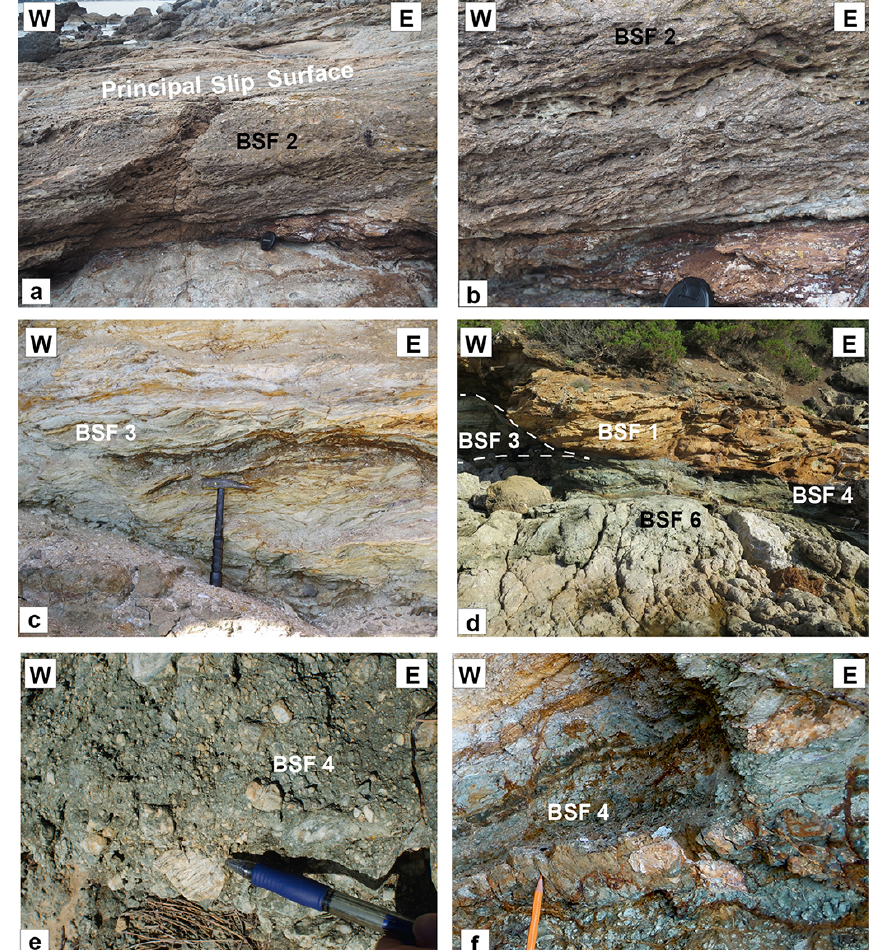
Figure 5. Outcrop view of fault rocks from different BSFs. Panels (a, b) show BSF 2. (a) Upper yellowish cohesive cataclasite with gently W-dipping foliation capped by the subhorizontal ZF principal slip surface. (b) Detail of foliated cataclasite with oblique foliation indicating top-to-the-east shearing. (c) Compositionally banded phyllonite of BSF 3. Note the shear bands constraining top-to-the-east shearing along the subhorizontal foliation. (d) Outcrop view of the complex spatial arrangement of four different BSFs at the western termination of the E–W section at Punta Zuccale. Note the eastern lateral closure of BSF 3, which forms a metric lens in the complex architecture of the ZF (see Fig. 2). The width of the photograph corresponds to ca. 8–10m. (e) BSF 4 greenish cataclasite with millimetric angular to subrounded quartz clasts deriving from underlying Triassic quartzites in a very fine-grained matrix made up of ultracataclasite and gouges. (f) Detailed view of a foliated gouge level within BSF